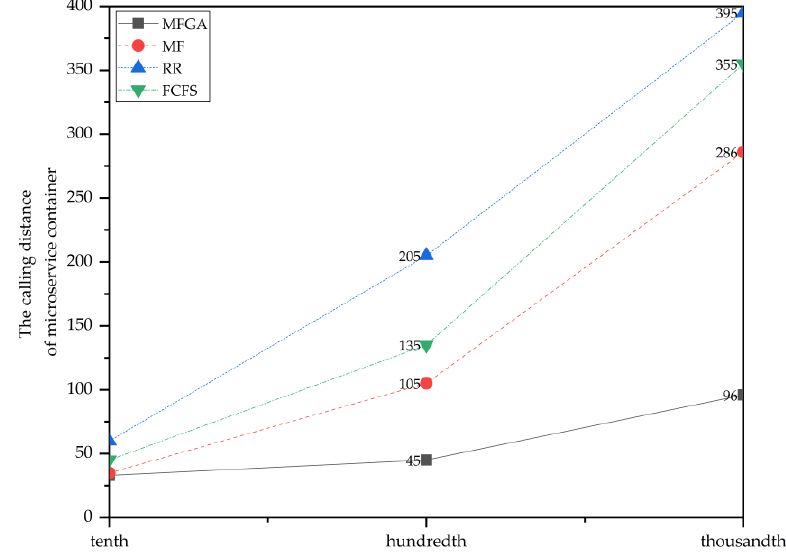
Figure 10. Comparison of microservice calling distance compared with four algorithms.